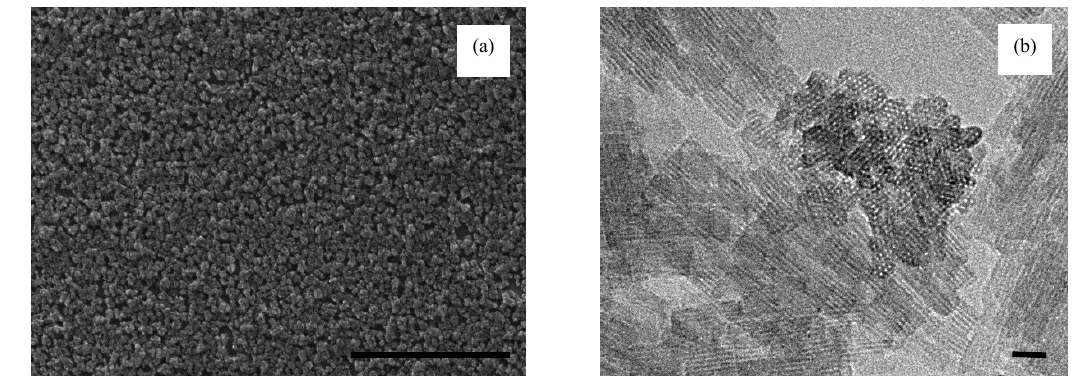
Figure 2. SEM (Scale bar, M = 2000 nm) ( a ) and high-resolution transmission electron microscope ( HRTEM) (Scale bar, M = 10 nm) ( b ) pictures of LTL nanosized zeolite.